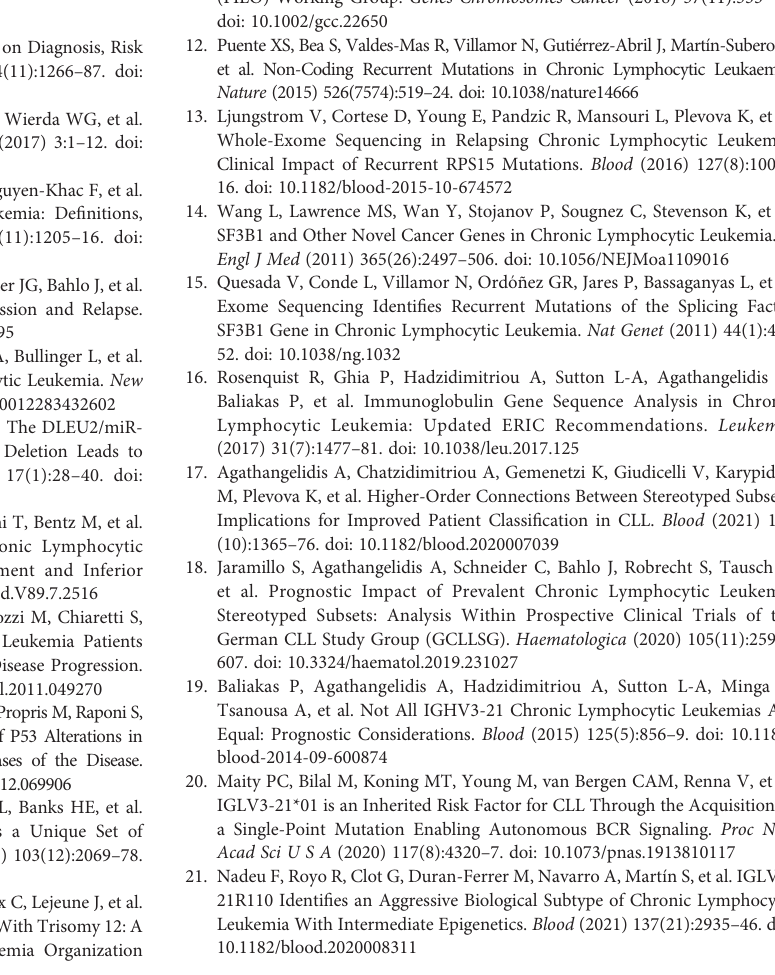
Supplementary Table 1 | Overview of CLL driver genes and KEGG pathways used to analyze the WGS data. Supplementary Table 2 | Genomic pro fi le for CLL loci for each family. Supplementary Table 3 | Samples utilized for WGS. Supplementary Table 4 | SNP array analysis results with relevant aberrations for complex karyotypes